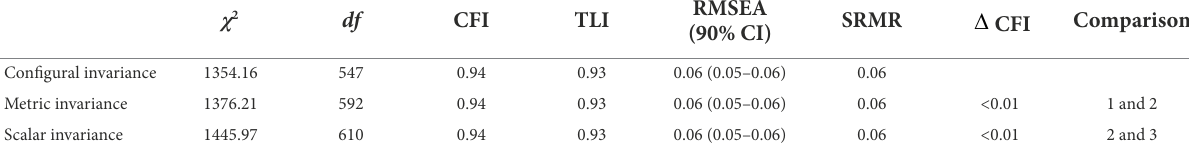
90% CI = 90% confidence